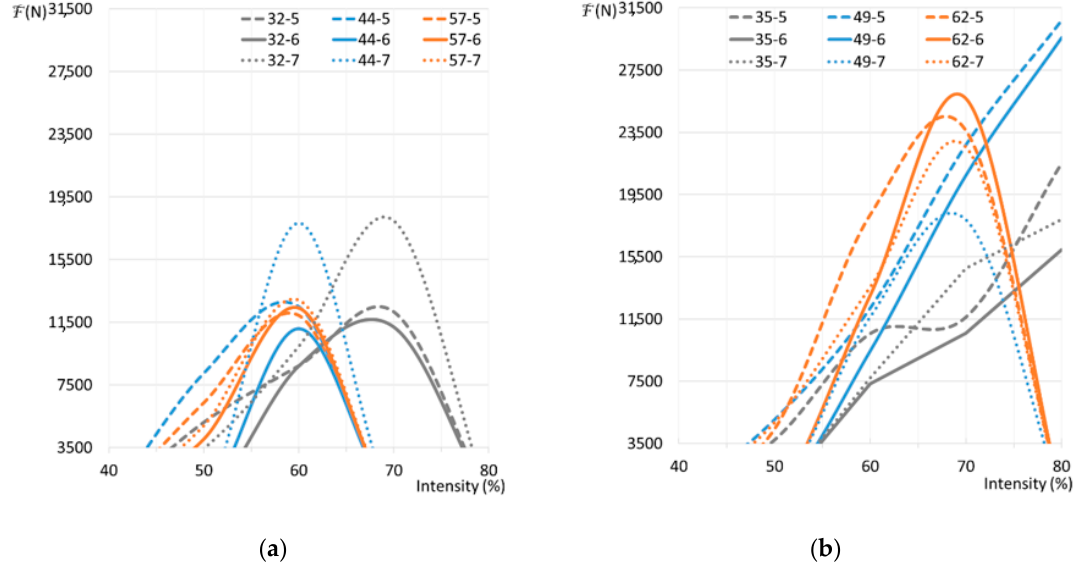
Figure 11. Force necessary for failure. Weld thickness: 20 mm ( a ) and 22 mm ( b ).